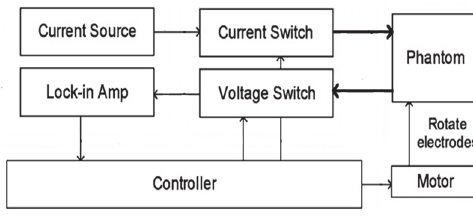
Fig. 4. Block diagram of a REIT system based on [20].